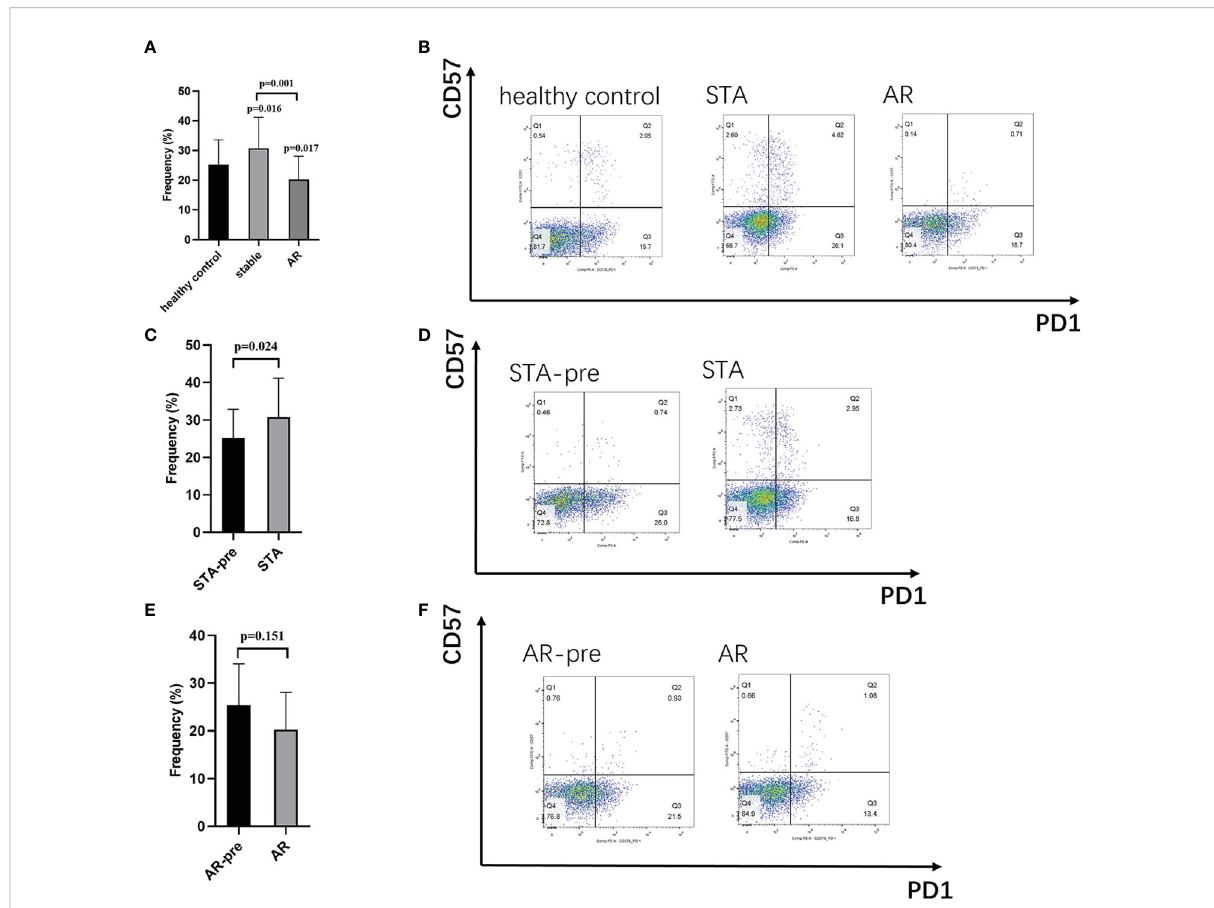
FIGURE 4 CD4+PD1+CD57- T cells in peripheral blood: (A) Recipients with acute rejection (AR) had signi fi cantly lower percentages of CD4+PD1+CD57- T cells compared with patients with stable renal function (STA) and the healthy control. (B) Representative histograms of CD4+PD1+CD57- T cell expression in the healthy control group, the STA group, and the AR group in fl ow cytometry. (C) Blood samples from the STA recipients had signi fi cantly higher percentages of CD4+PD1+CD57- T cells compared with pretransplant blood samples from recipients with stable renal function within 1 year after transplantation (STA-pre). (D) Representative histograms of CD4+PD1+CD57- T cell expression in the STA-pre group and the STA group in fl ow cytometry. (E) Blood samples from recipients with AR had signi fi cantly higher percentages of CD4+PD1+CD57- T cells compared with preoperative blood samples from those that occurred acute rejection within 1-year after transplantation (AR-pre). (F) Representative histograms of CD4+PD1+CD57- T cell expression in the AR-pre samples and the AR in fl ow